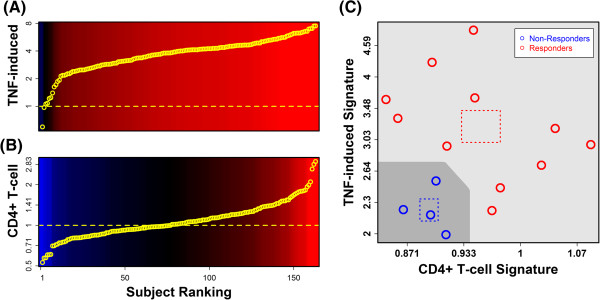
Signatures calculated from TNF-induced genes and genes specifically expressed in CD4+ T-cells can differentiate between etanercept responders (n = 11) and non-responders (n = 4). We identified TNF and CD4+ T-cell signatures that differentiate between etanercept responders and non-responders, based upon paired lesional (PP) and non-lesional (PN) samples obtained at baseline prior to etanercept treatment (Additional file 11). The TNF signature is calculated as the weighted average of fold-changes (PP/PN) of 6 genes induced by treatment of KCs with TNF (10 ng/mL) for 24 hours (GSE36287; Additional file 11, Part B), while the CD4+ T-cell signature is calculated as the weighted average of fold-changes (PP/PN) of 7 genes specifically expressed in CD4+ T-cells (Additional file 11, Part A). Parts (A) and (B) show the distribution of signature scores among 163 patients. In part (C), signature scores from 11 etanercept responders and 4 non-responders are plotted. Dotted squares outline the bivariate mean for each group (± 1 standard error along each axis). The dark region (lower left) outlines a proposed decision boundary for classification of patients as etanercept non-responders.